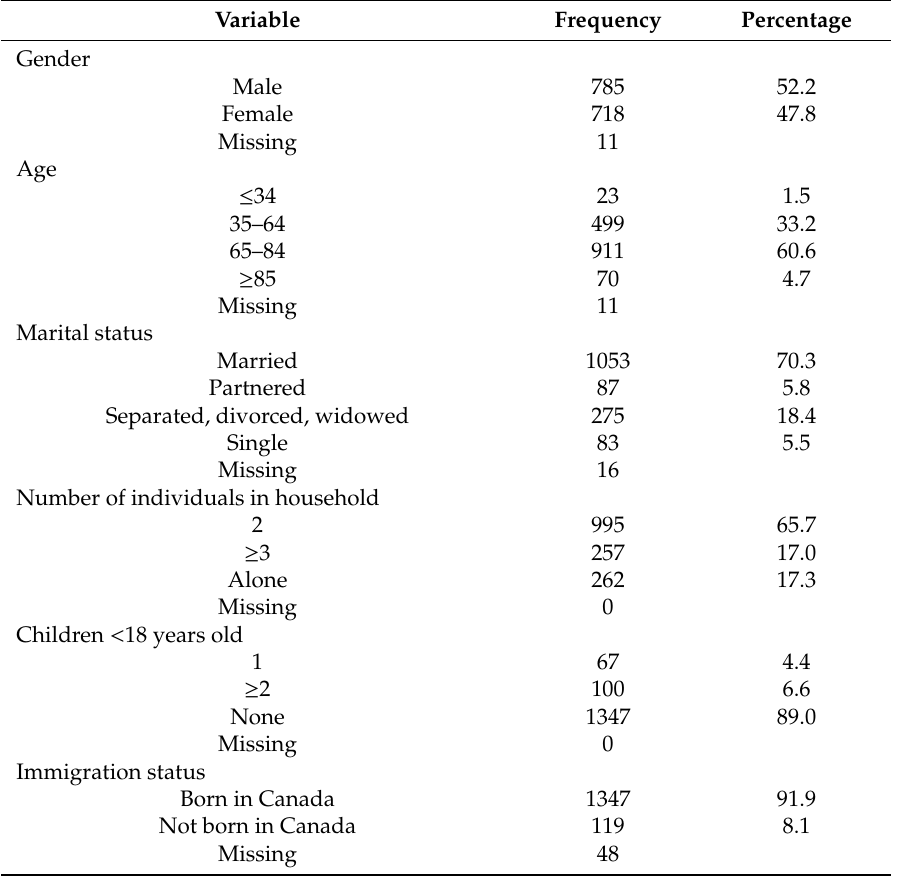
Table 2. Demographic and clinical characteristics of survey